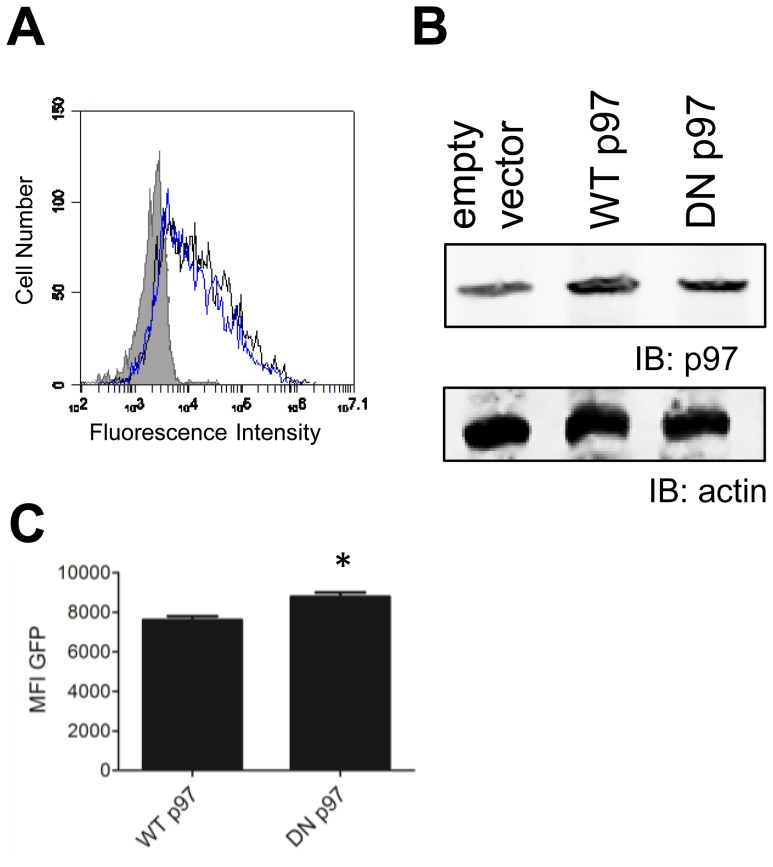
Transfected EL4/SCRAP cells express elevated levels of p97 protein.
A. EL4/SCRAP cells were transfected with pMSCV containing an IRES insert that allowed for dual expression of Thy1.1 and either wild type (black trace) or a dominant-negative mutant (blue trace) of p97. Cells were stained with anti-Thy1.1 antibody 24 hours post transfected and analyzed by FACS. Representative histograms are shown with the isotype control antibody staining represented by the shaded histogram. B. Total cell lysates from cells transfected with wild type (WT) or dominant negative (DN) p97 vectors were prepared 24 hours after transfection and resolved by SDS-PAGE followed by western blot analysis for p97 protein and actin. C. EL4 cells were transfected with constructs encoding a mutated TCRα- GFP construct and either WT or DN expression plasmids. The following day Thy1.1 cells were analyzed for GFP expression. DN transfected cells had elevated levels of GFP (p<0.05) indicating inhibited ERAD function.